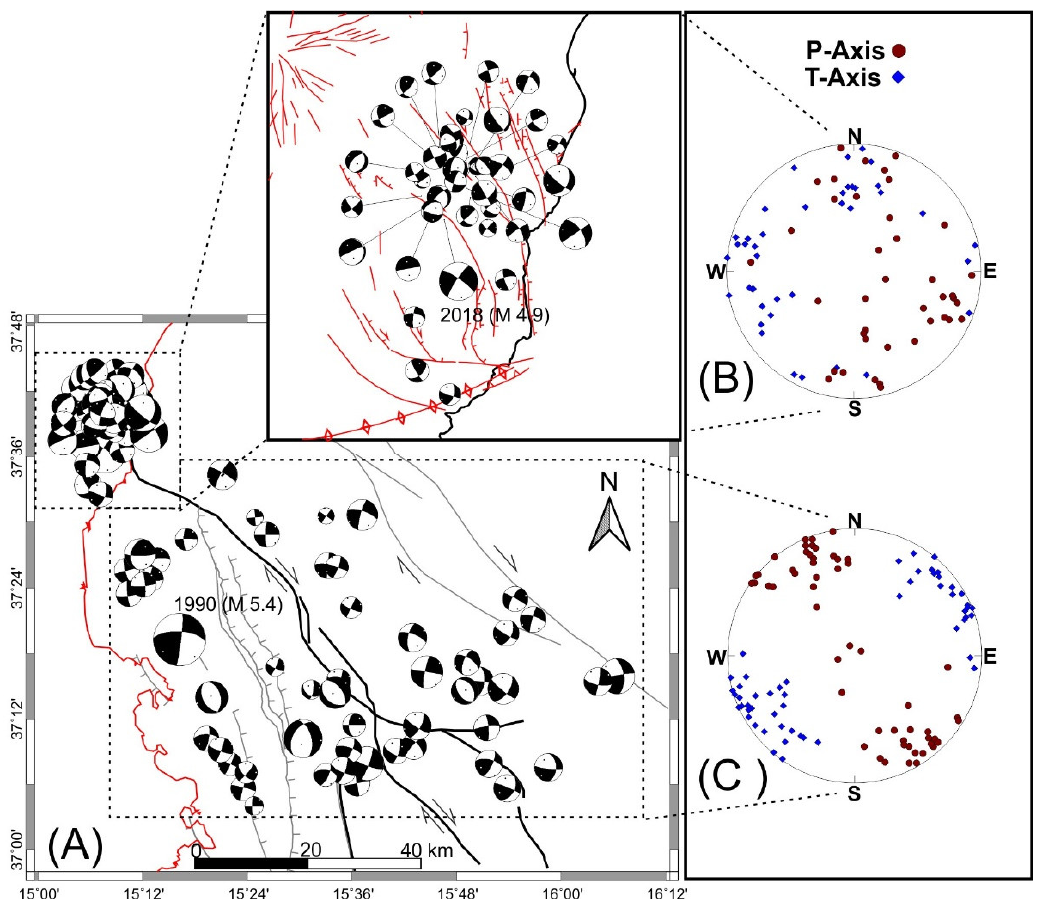
Figure 12. ( A ) Map showing the focal solutions deduced from data collected by Scarfì et al. [40]. Diagrams ( B ) and ( C ) show P–T axes distribution in the Etnean and Ionian areas, respectively.